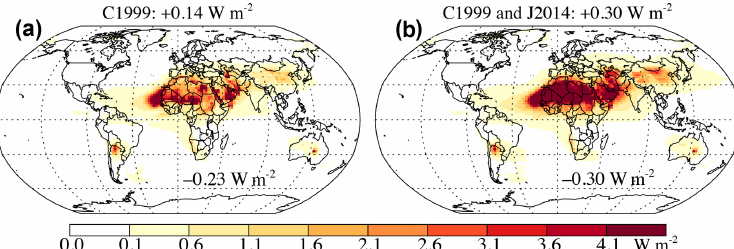
Figure 15. As in Fig. 11 but for the shortwave DRE uncertainty estimated based on a combination of five models (CAM5, CAM6, ModelE2, GFDL, MONARCH). Panel (a) only includes soil distribution of minerals and their uncertainty in the C1999 soil atlas. Panel (b) further includes the difference between C1999 and J2014 and uncertainty in J2014. Note that the shortwave DREs for ModelE2 and GFDL are obtained through regressions (see Sect. 2.3.4). Numbers show the high (in the title) and low branches (inlet numbers) of the global mean